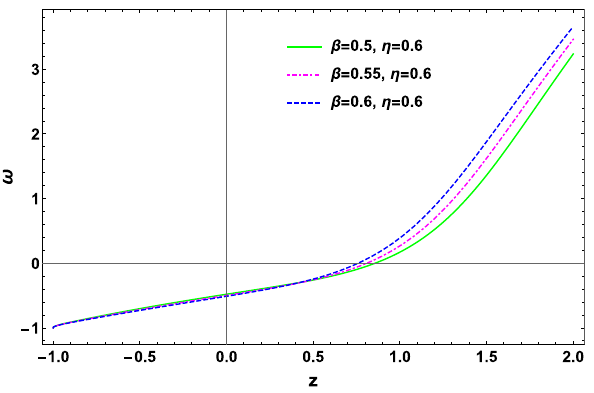
Fig. 19 Variation of EoS parameter against z with m = 0 . 2, n = 0 . 05, λ = 0 . 5